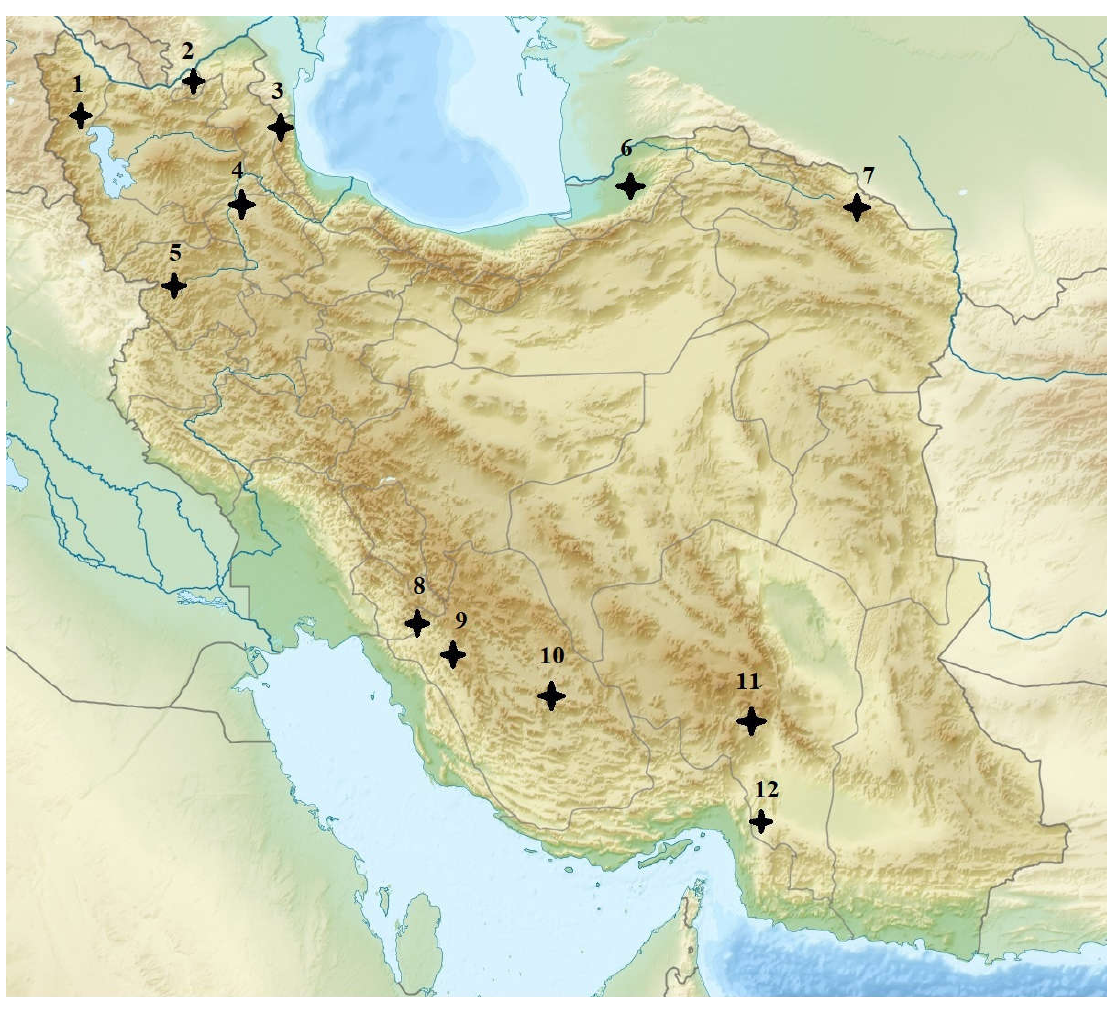
Fig.1. Sampling sites of Sylvia Warblers in Iran: 1=Khoy; 2=Arasbaran; 3=Khalkhal; 4=Zanjan; 5=Kurdistan; 6=Golestan; 7=Tandoureh; 8=Yasuj; 9 and 10=Fars; 11=Kerman; 12=Minab. Much of the sampling was done in